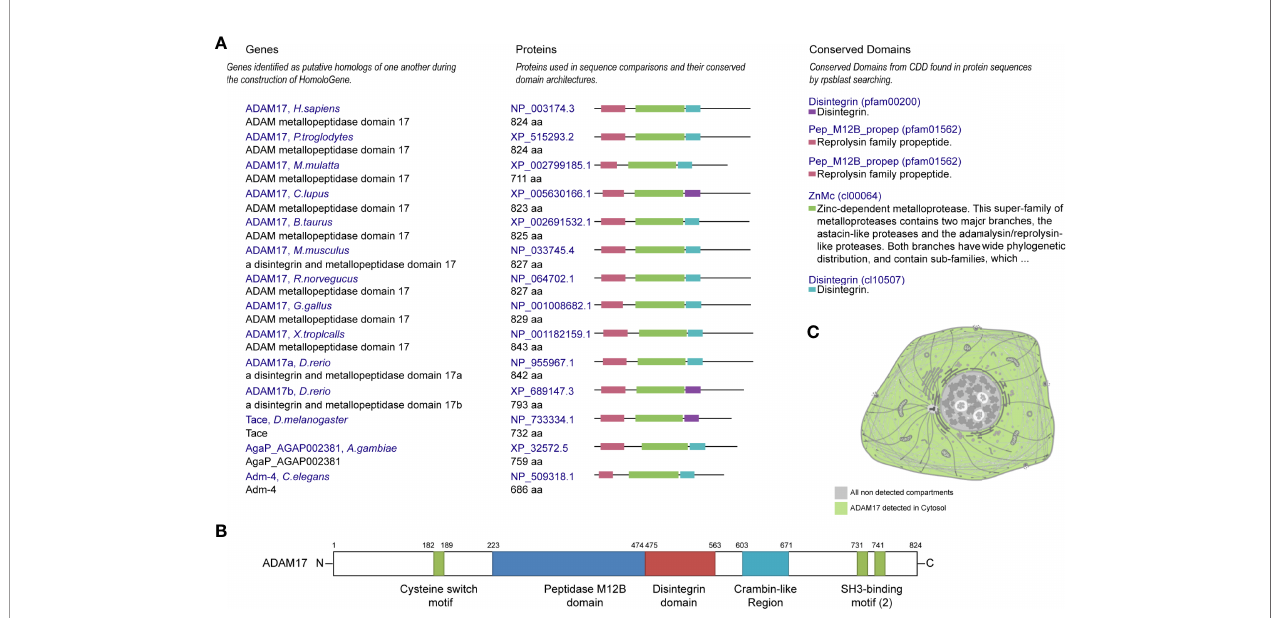
FIGURE 1 | Conservation, structure, and cellular localization of ADAM17 in humans. (A) Conservation for ADAM17 in the indicated different species. (B) Structures of ADAM17. (C) A diagrammatic sketch of ADAM17 cellular localization. Green indicates ADAM17 in the cytosol, whereas gray indicates the